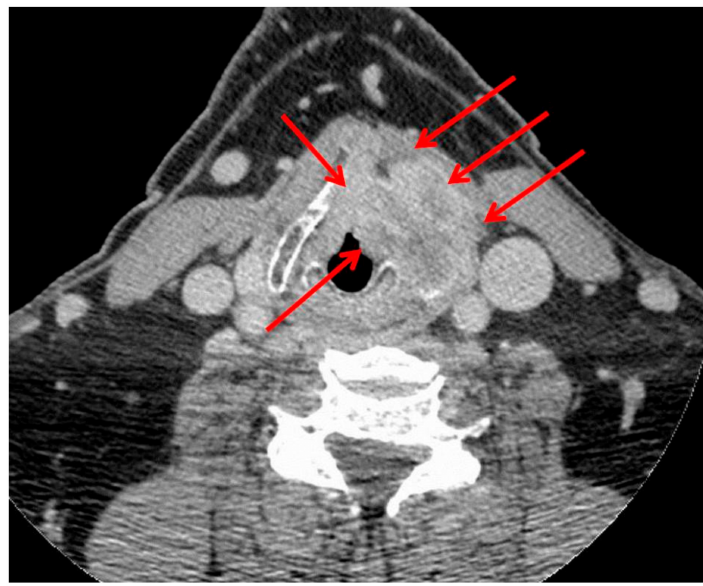
Figure 3. CT scan of a 72-year-old patient with T4a laryngeal cancer (red arrows) showing a large extralaryngeal extension through the left side of the thyroid cartilage. Indication of primary total